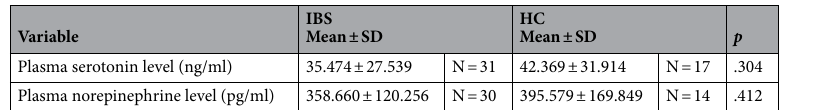
Table 3. Difference in plasma neurotransmitters levels between IBS and control groups. IBS, irritable bowel syndrome; HC, healthy